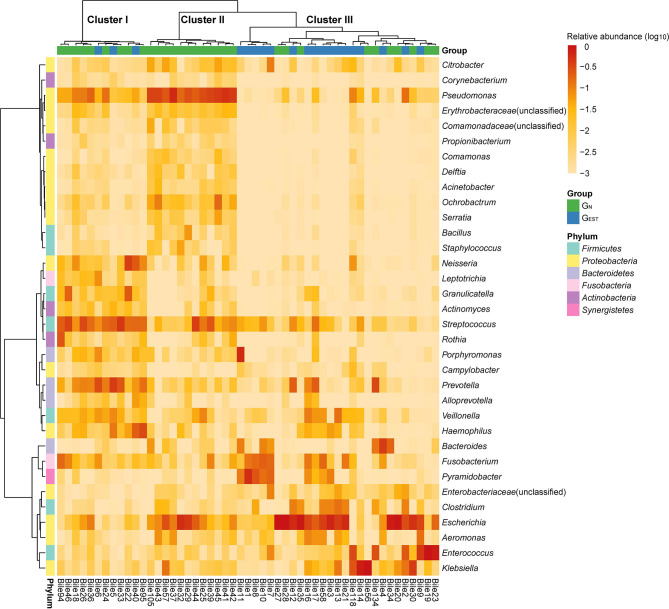
Distribution of highly prevalent genera in the GEST and GN groups. Only genera detected in at least 20% samples with a relative abundance ≥0.1% were displayed. The heatmap color scale quantifies the log10 relative abundance of each genus.